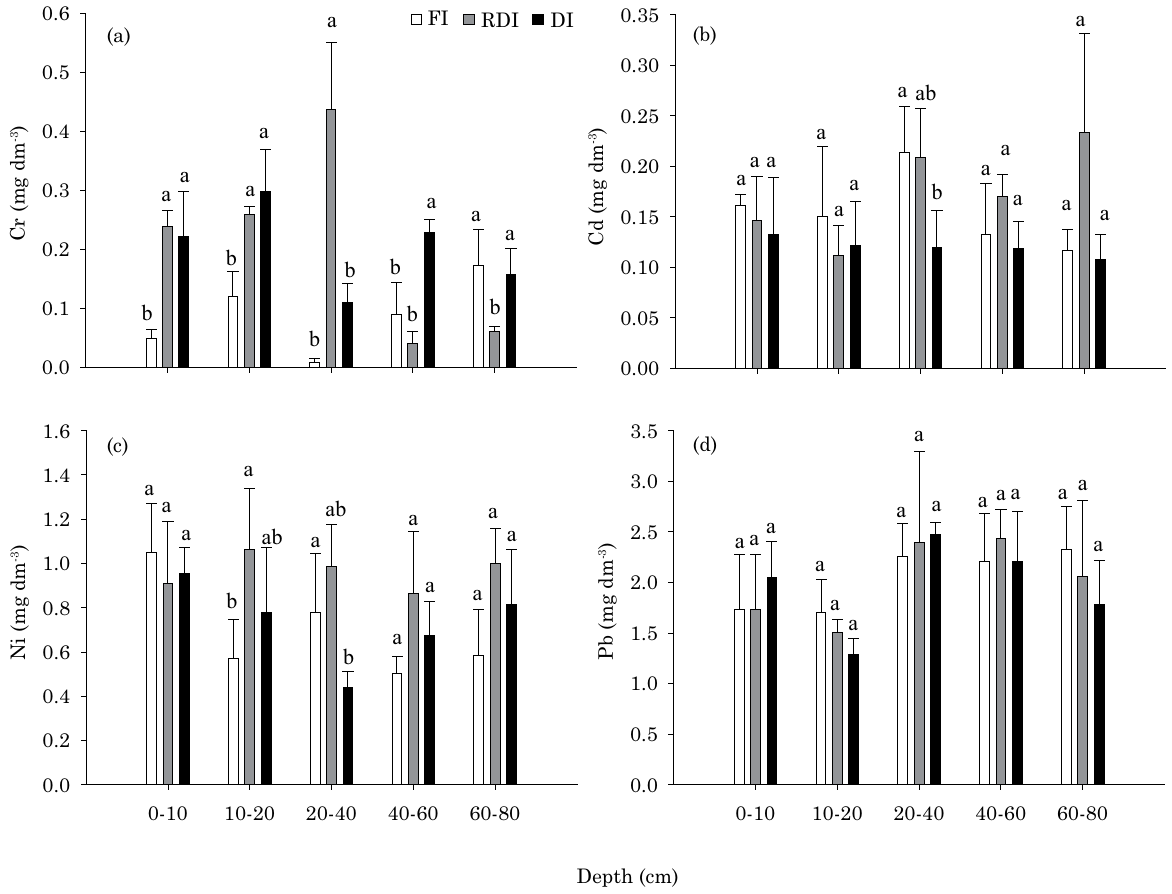
Figure 3. Heavy metal contents in the soil cultivated with grapevines in accordance with different irrigation strategies - full irrigation (FI), regulated deficit irrigation (RDI), and deficit irrigation (DI). Columns followed by the same letter at the same depth do not differ among themselves by the Tukey test at 5 % of significance. The vertical deviation bars represent the standard deviation of the mean value (n =